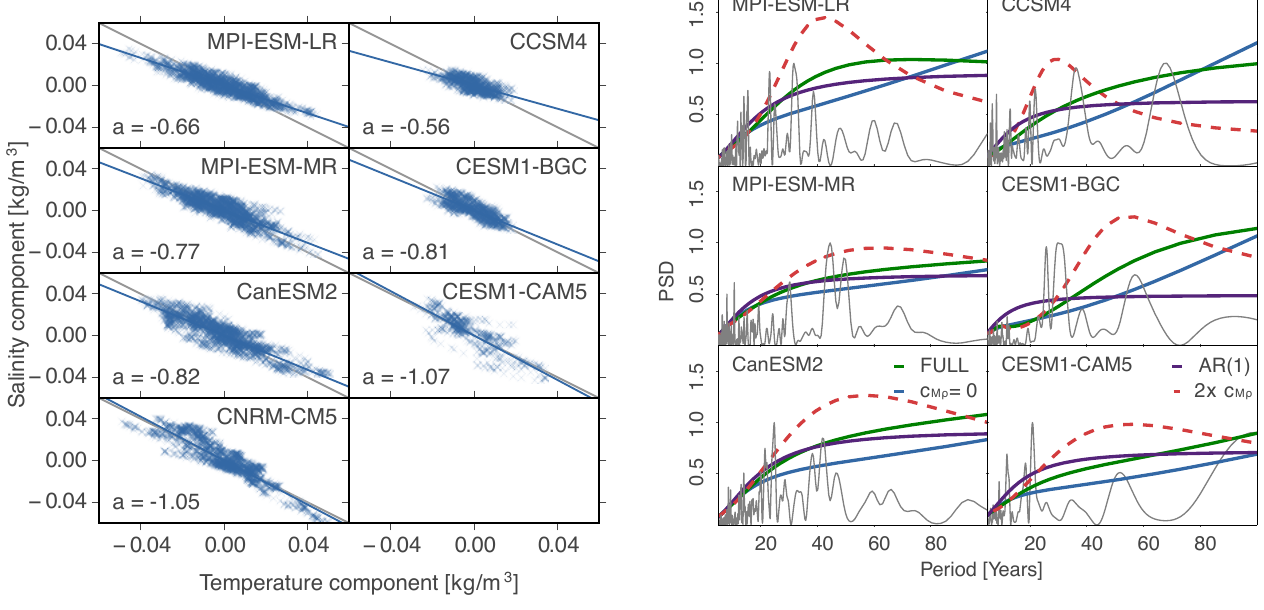
Fig. 8. Relation of temperature and salinity driven NADO density changes. The blue line marks the linear fit with slope a . The a = − 1 line is drawn in grey.